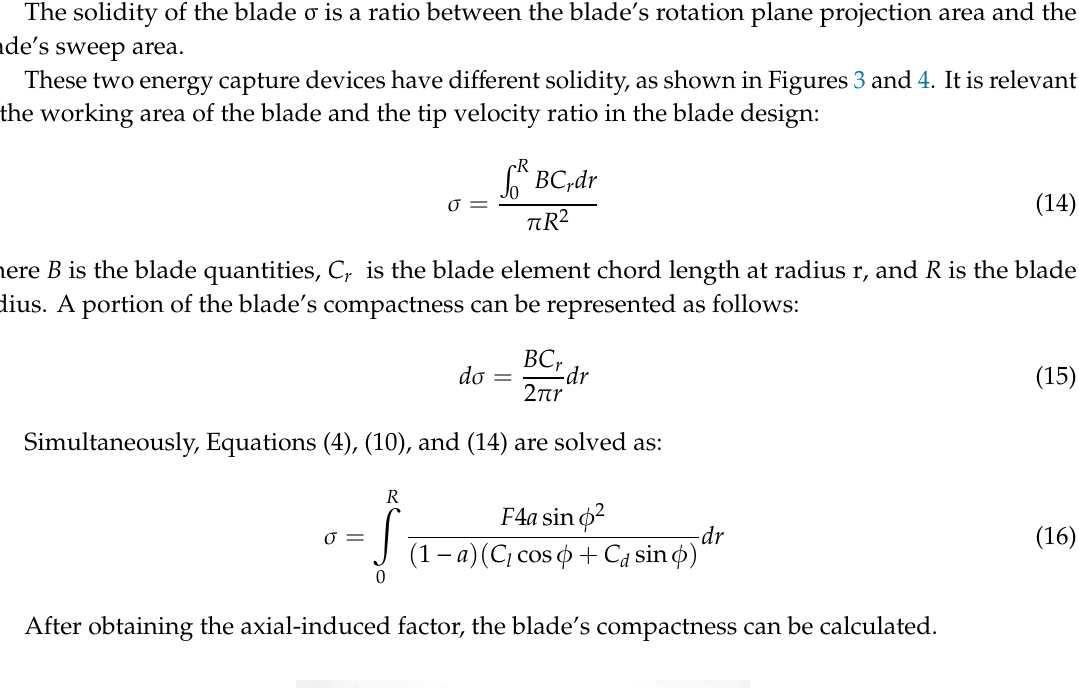
Figure 4. Turbine of Zhejiang University.